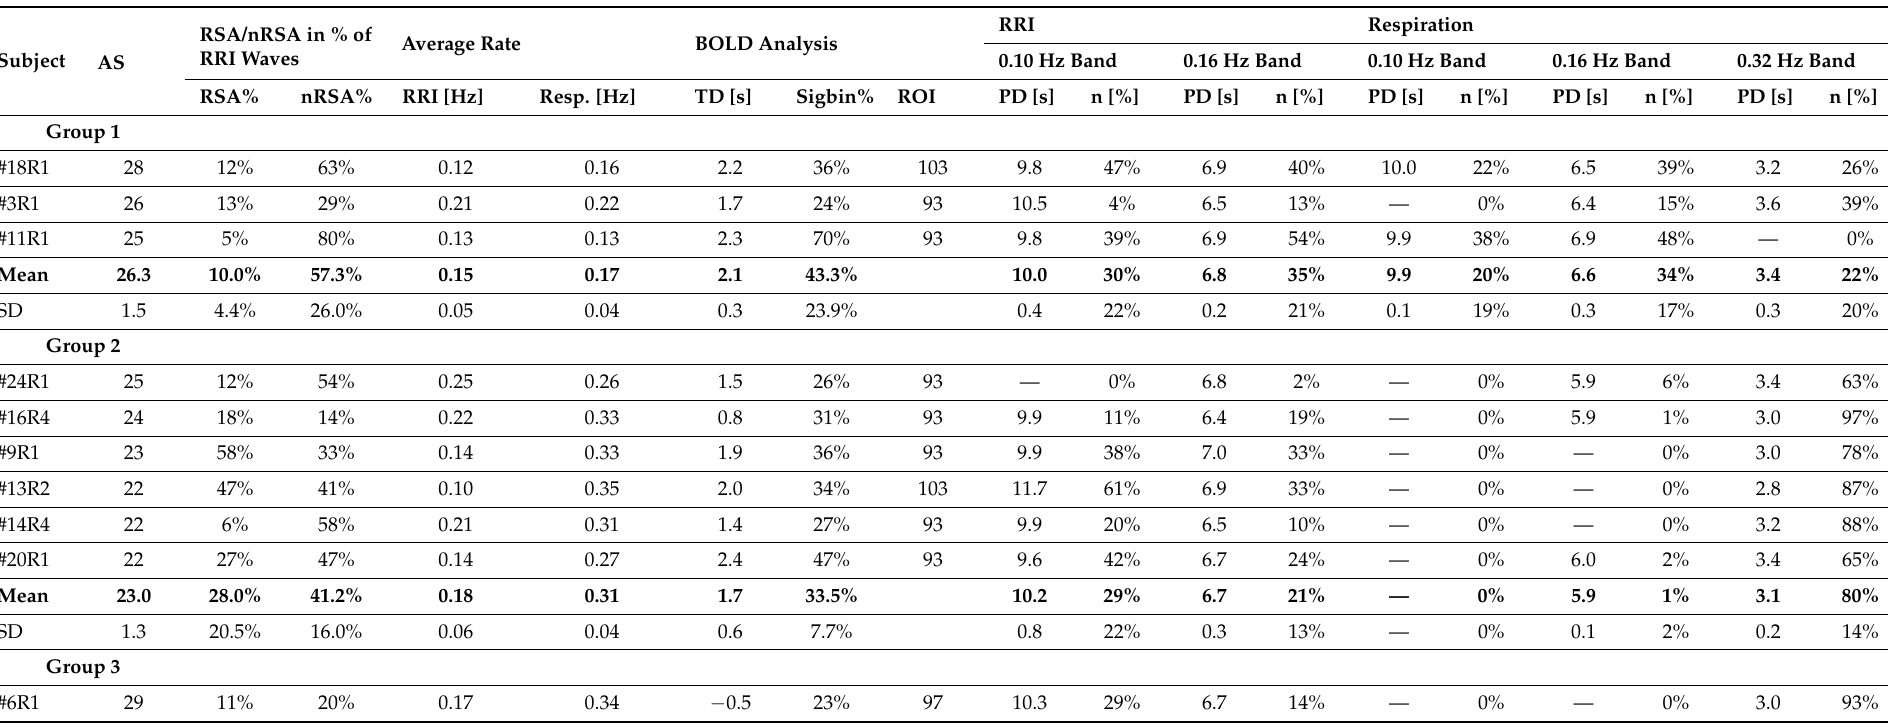
Table 1. Results of the wave-by-wave analysis and BOLD analysis from 10 fMRI participants (allocated to 3 groups as described in the text) with high anxiety (modified from